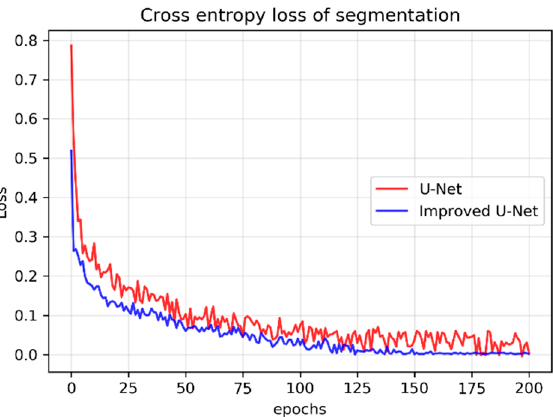
Figure 11. Improvement of U-Net.